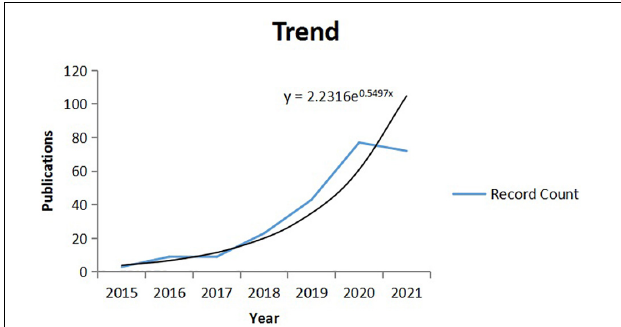
FIGURE 7 | Year distribution of the articles between 2015 and